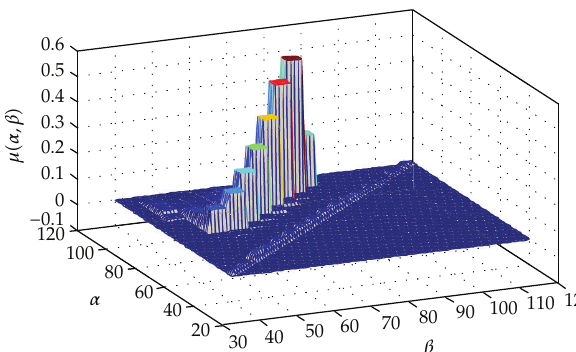
Figure 16: Approximated μ (cid:2) α,β (cid:3) surface by use of linear equation system optimization (cid:2) Shirley Approach (cid:3) .